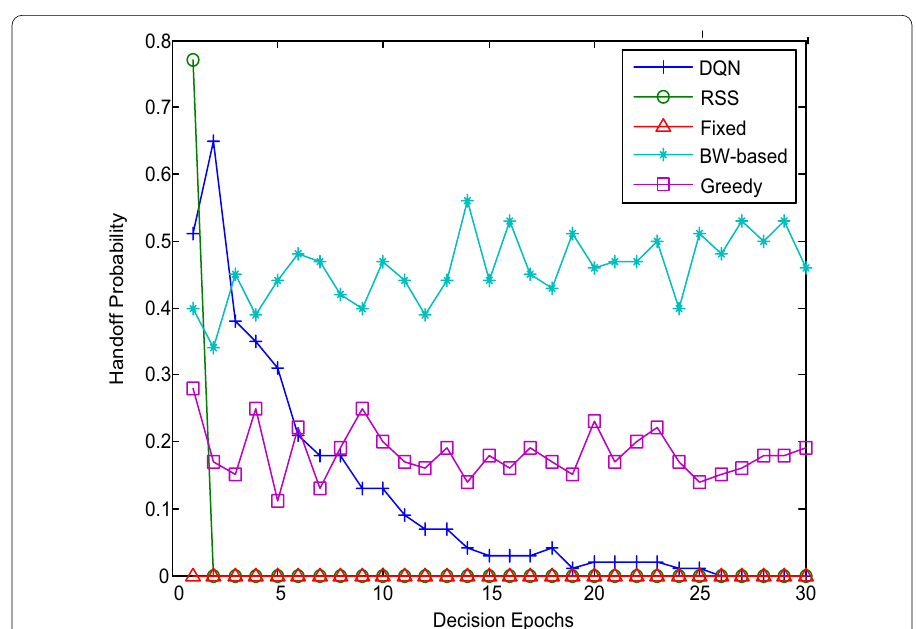
Fig. 6 Handoff probability. We compare the handoff probability of different algorithms with the progress of the handover decision in this figure. In the initial stage of decision-making, the handoff probability number of DQN algorithm is higher than greedy, RSS and fixed algorithm. However, as the decision progresses, the handoff probability of DQN algorithm decreases